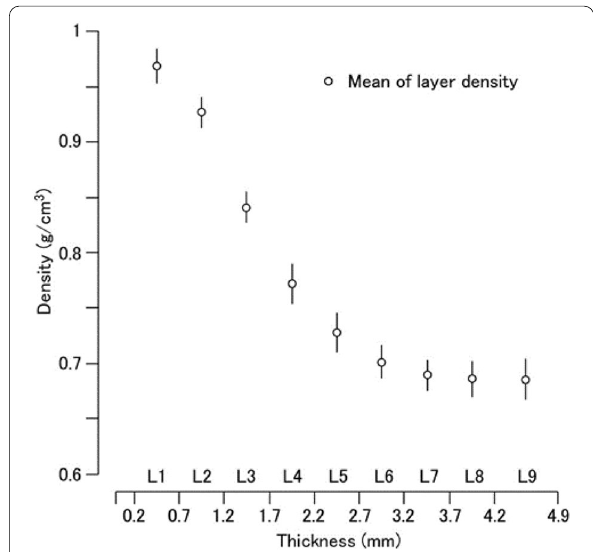
Fig. 5 Relationship between thickness and mean layer density. Error bars denote standard deviations